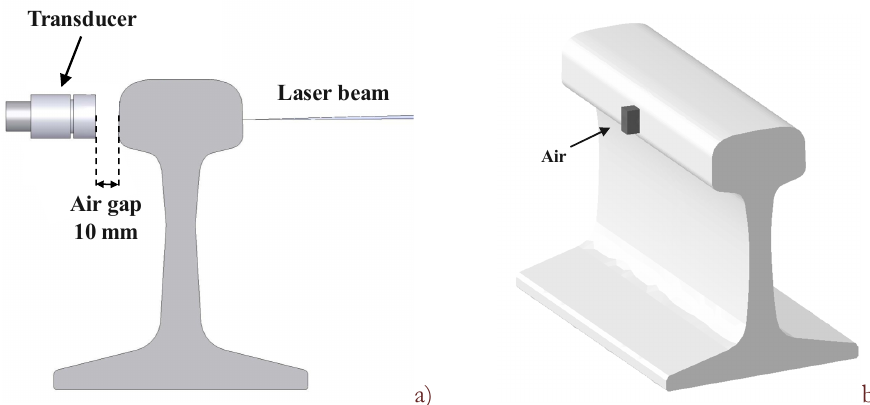
Figura 15: a) Schema del setup sperimentale e b) modello agli elementi finiti della